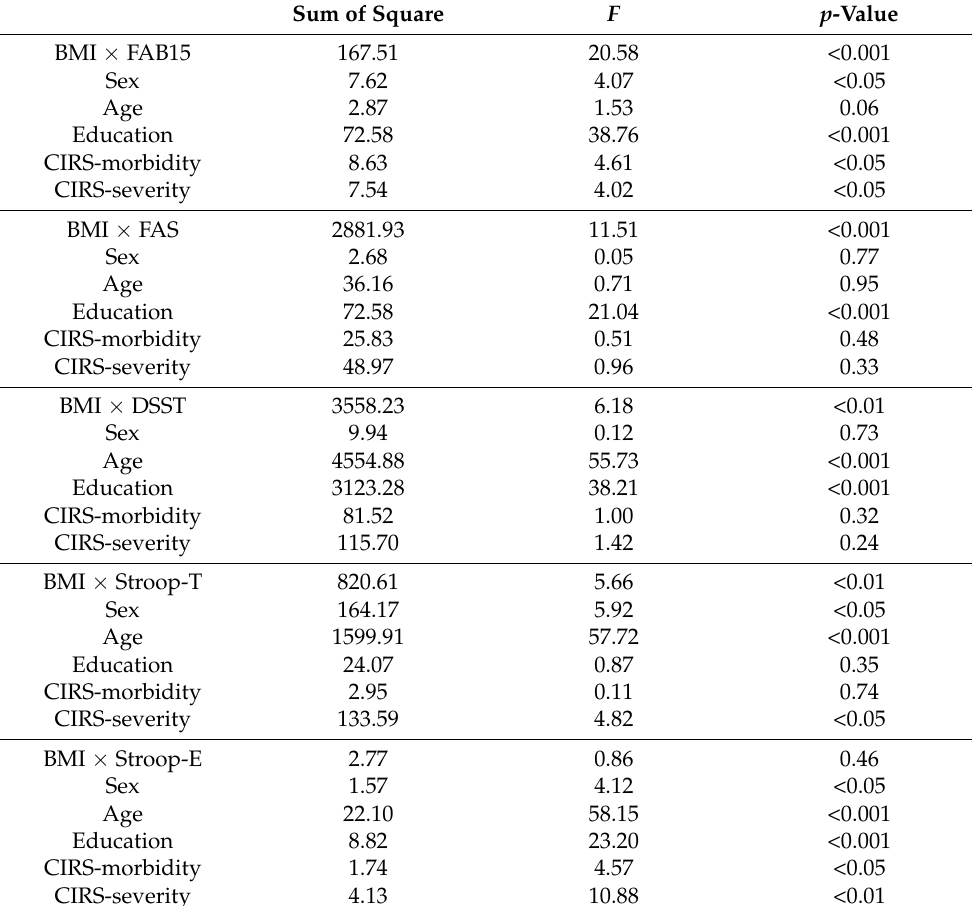
Table 3. Analyses of Covariance.